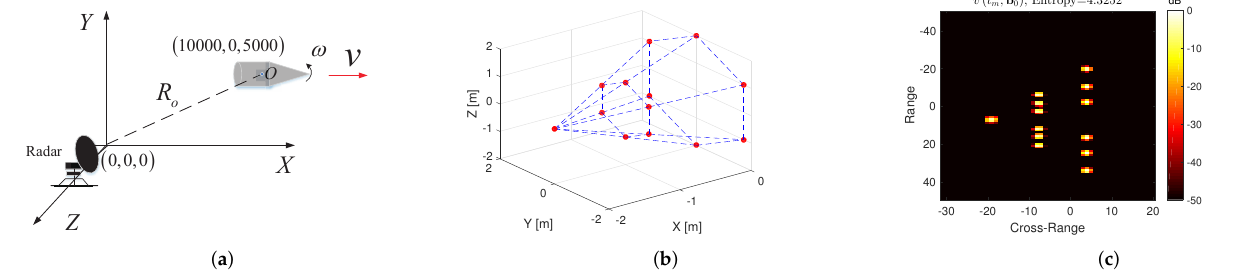
Figure 5. ( a ) Target movement trajectory; ( b ) the scattering point model; and ( c ) the ideal image of zero velocity.